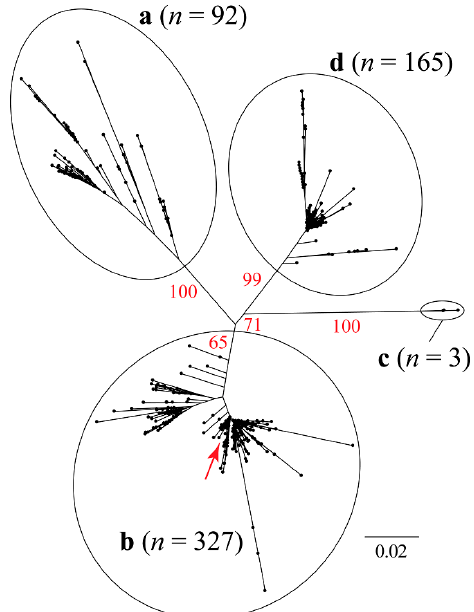
Figure 2. Unrooted maximum likelihood tree based on 1650 bp of the PCV2 capsid + concatenated replicase genes. The red arrow shows approximately the phylogenetic position of the sequence that was recovered in Rancangua in 2007. The genotype classification (a, b, c, and d) follows Franzo et al. (2015) [37] (Supplementary Material, Table S1). In red, the bootstrap values based on 1000 replicates are indicated for the main internal branches.